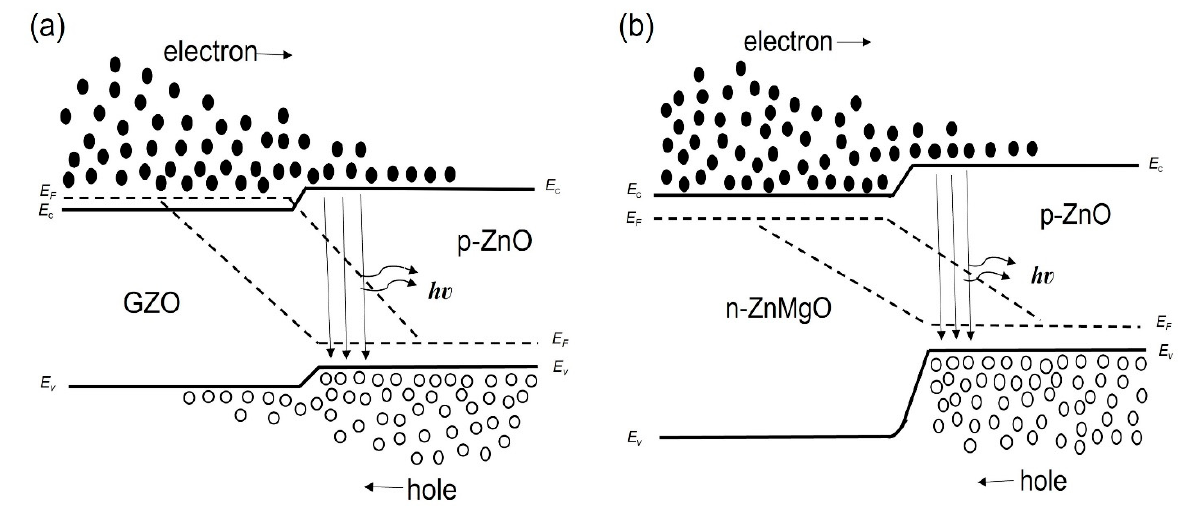
Figure 5. Band diagrams under forward bias conditions (band bending is not taken into account) ( a ) p-ZnO/GZO homojunction; ( b ) p-ZnO/n-ZnMgO heterojunction.